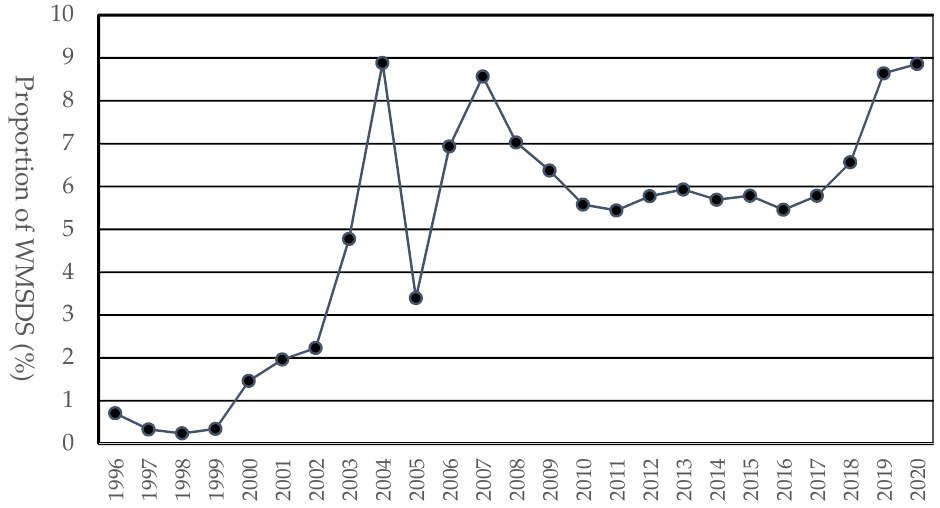
Figure 3. Proportions of WMSDs among industrial accidents by year. The rates of low back pain among WMSDs ranged from 28.2% to 82.0% (Figure 4). The rate soared from 28.2% in 2004 to 82.0% in 2007 and was higher than 70.0% from 2006 to 2012. The ratios have steadily declined from 2012 and have been approximately 45% in the last three years.